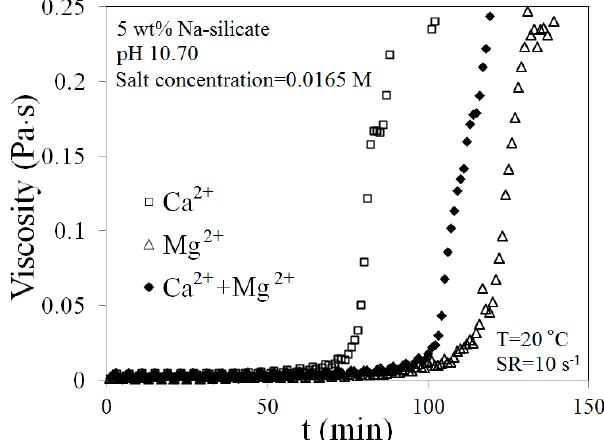
Figure 11. Viscosity as a function of time for a 5 wt% Na-silicate solution with a pH containing 0.0165 M of Ca 2+ , Mg 2+ and equivalent both